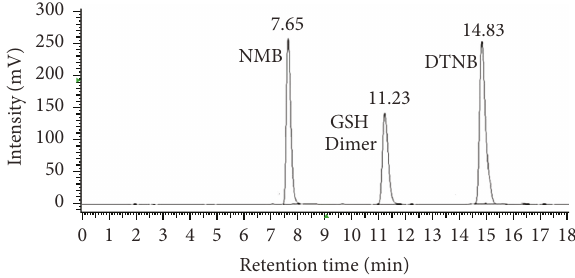
Figure 2: Representative chromatogram from 6 replicates is shown. 2-Nitro-5-mercapto-benzoic (NMB) acid, glutathione dimer (GSH